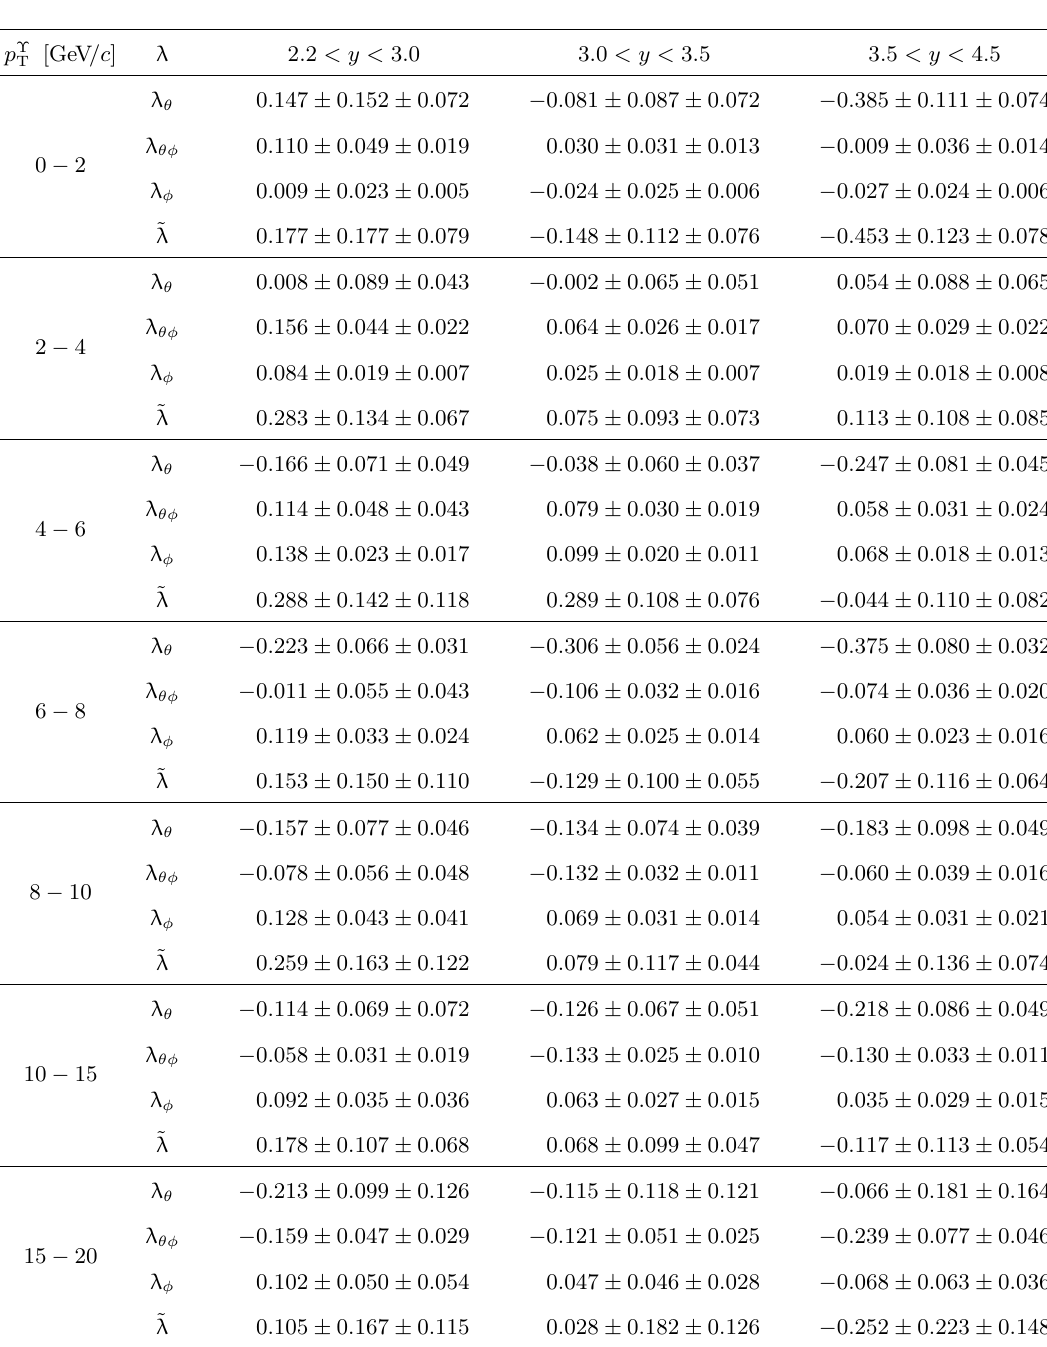
Table 25 . Values of (cid:21) (cid:18) , (cid:21) (cid:18)(cid:30) , (cid:21) (cid:30) and ~ (cid:21) measured in the GJ frame for the (cid:7)(3S) produced at p s = 8 TeV. The (cid:12)rst uncertainty is statistical and the second